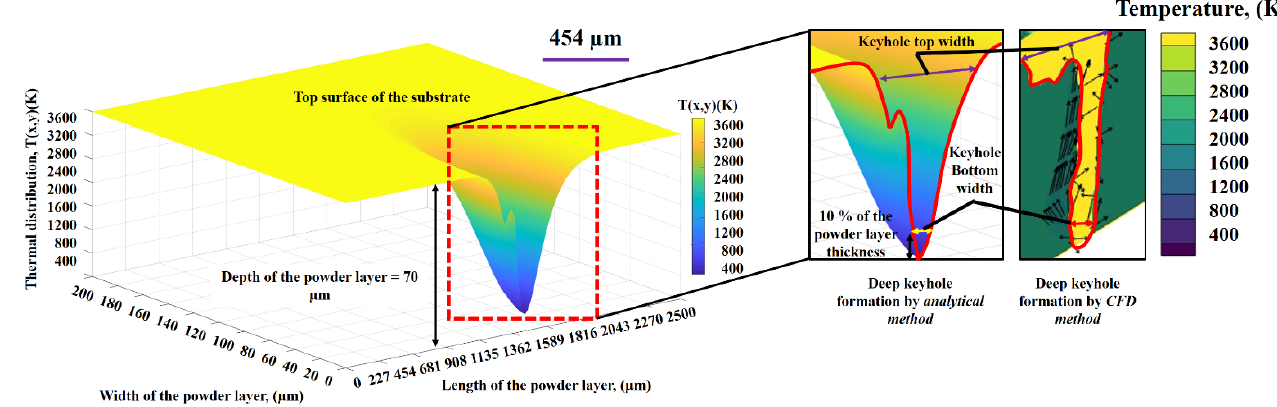
Figure 10. A comparison between analytical and CFD simulation results for peak thermal distribution value in the deep keyhole formation.